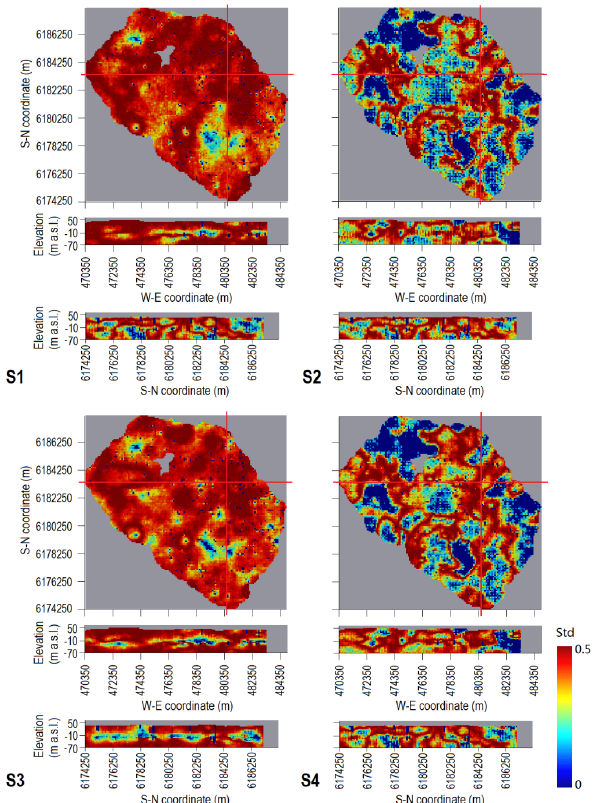
Figure 12. Map of standard deviation over the 50 realizations of Figure 12: Map of standard deviation over the 50 realizations of each scenario. The computation 2 each scenario. The computation of standard deviation is based on of standard deviation is based on binary geological units (0 for Quaternary sand and 1 for 3 binary geological units (0 for Quaternary sand and 1 for Quaternary Quaternary clay). The standard deviations are 0 at cells where the boreholes are located. The 4 clay). The standard deviations are 0 at cells where the boreholes are horizontal plane is taken at 10 m a.s.l.. 5 located. The horizontal plane is taken at